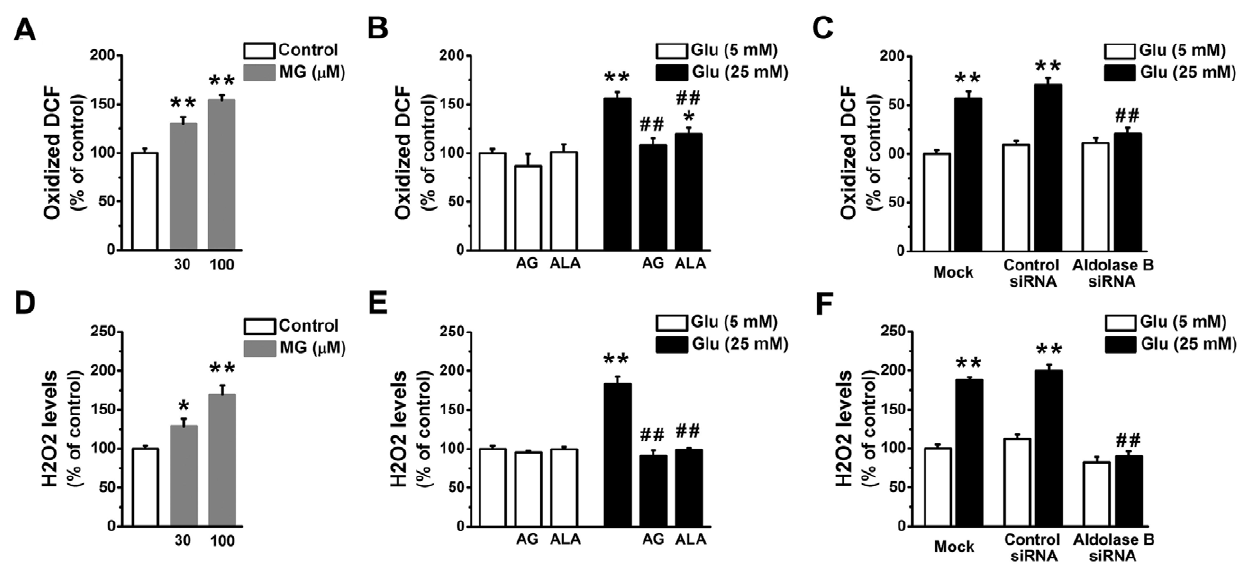
Figure 3. Knockdown of aldolase B prevented the increase of oxidized DCF and H 2 O 2 levels in high glucose-treated EA. hy926 cells. Levels of oxidized DCF (A) in cells treated with exogenous MG (** P , 0.01 vs. control), (B) in cells treated with glucose in the presence or absence of aminoguanidine (AG, 1 mM) and alagebrium (ALA, 100 m M) (* P , 0.05, ** P , 0.01 vs. 5 mM glucose; ## P , 0.01 vs. 25 mM glucose), and (C) in cells transfected with control or aldolase B siRNA, or only transfection agent (mock) (* P , 0.05, ** P , 0.01 vs. 5 mM glucose; ## P , 0.01 vs. control siRNA). Levels of H 2 O 2 (D) in cells treated with exogenous MG (* P , 0.05, ** P , 0.01 vs. control), (E) in cells treated with glucose in the presence or absence of aminoguanidine (AG, 1 mM) and alagebrium (ALA, 100 m M) (** P , 0.01 vs. 5 mM glucose; ## P , 0.01 vs. 25 mM glucose), and (F) in cells transfected with control or aldolase B siRNA, or only transfection agent (mock) (** P , 0.01 vs. 5 mM glucose; ## P , 0.01 vs. control siRNA).